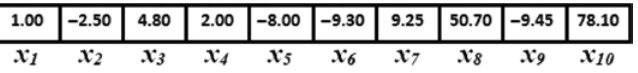
Figure 1: Example of Solution Representation